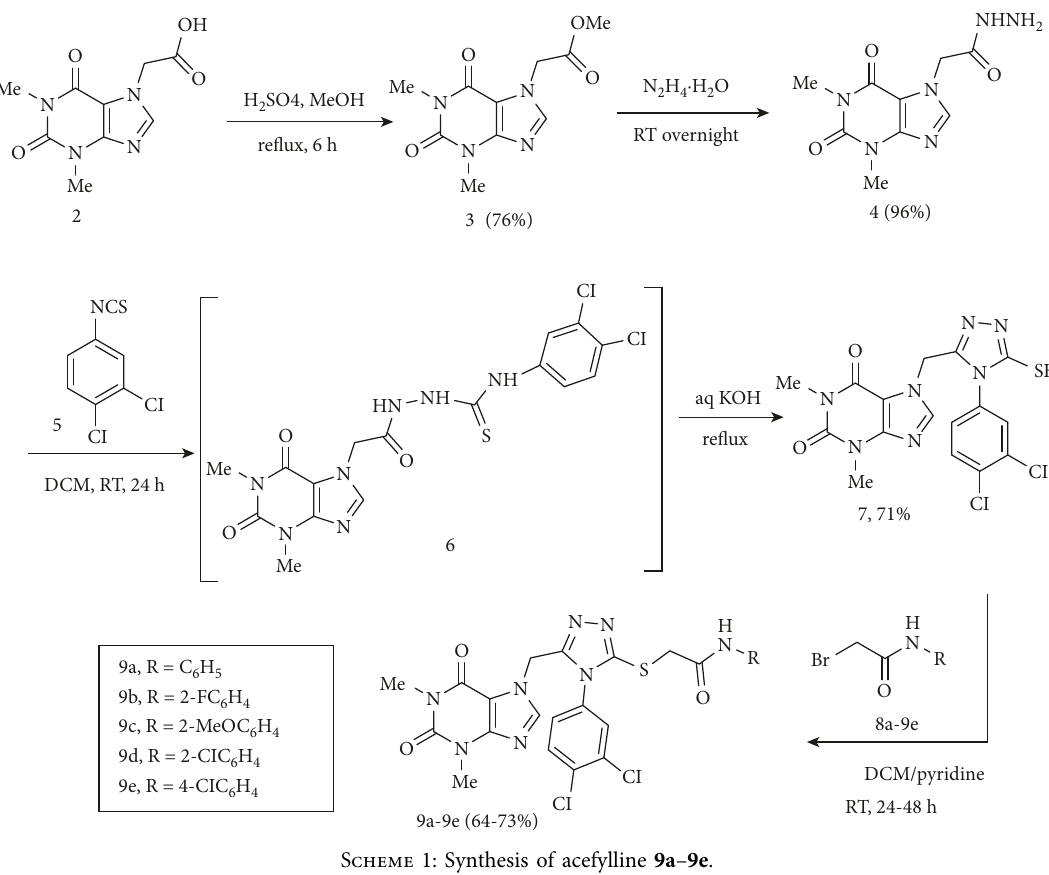
Scheme 1: Synthesis of acefylline 9a – 9e .